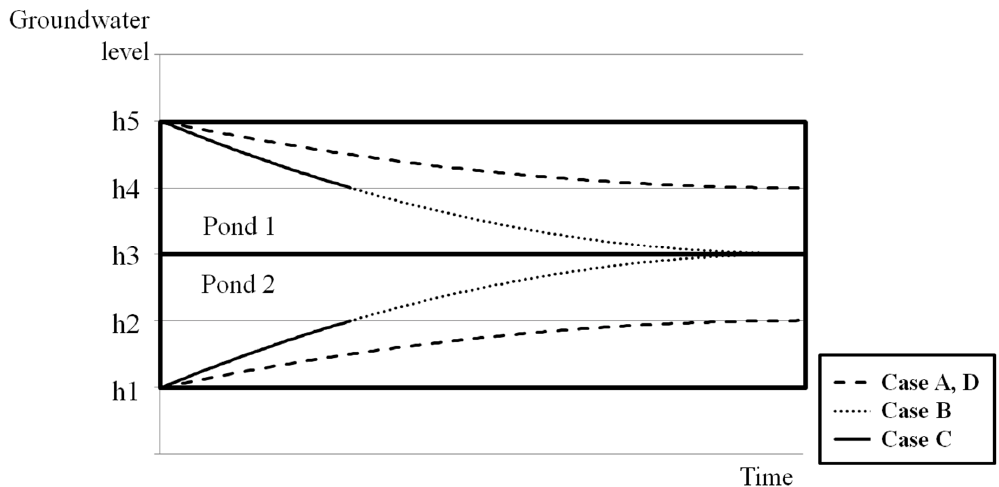
Figure 2. Groundwater level variations according to time for each case in Figure 1.